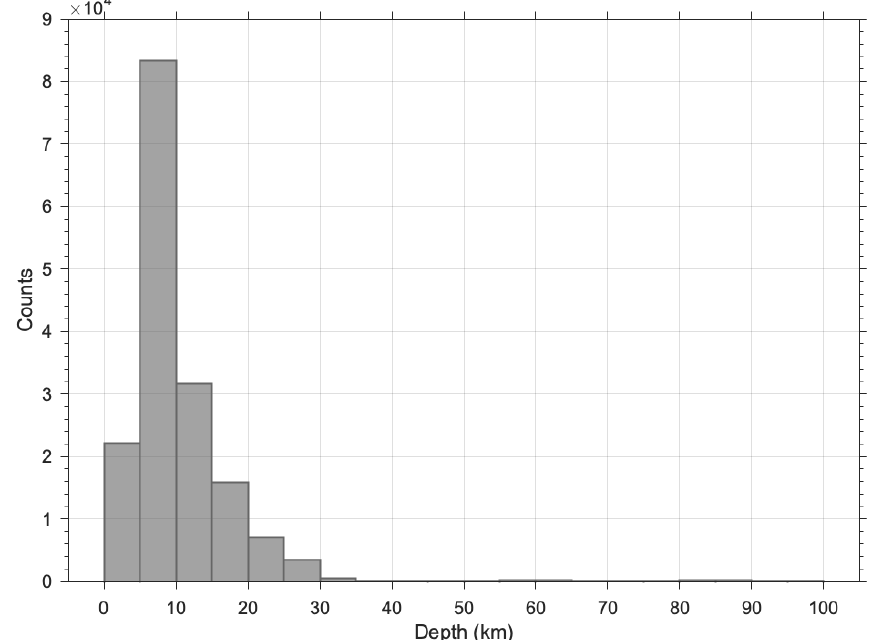
Figure 4. Earthquake – depth histogram for the time interval 1 January 2008–31 December